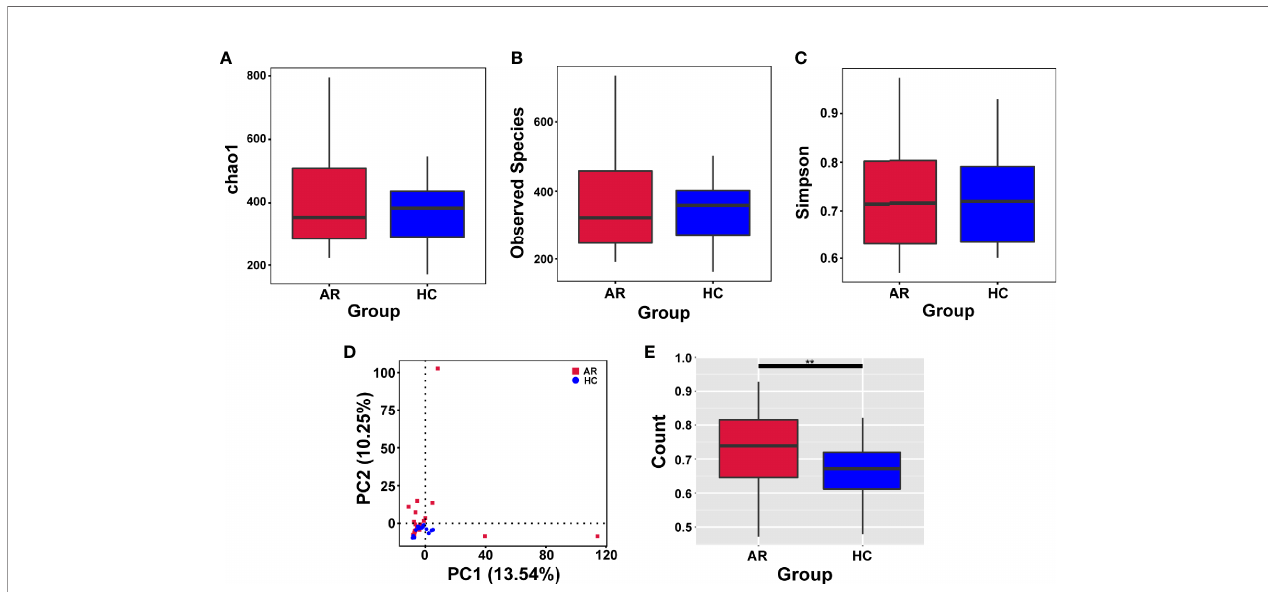
FIGURE 2 | Alpha-diversity analysis of microbiome in allergic rhinitis (AR) group and healthy control (HC) group. (A) Chao1 index statistics. (B) Observed species index statistics. (C) Simpson index statistics. (D) Display of Principal Component Analysis (PCA) of the samples in two-dimension (PC1 = 13.54%, PC2 = 10.25%). (E) Beta diversity index statistics. Student ’ s t-test, **p <